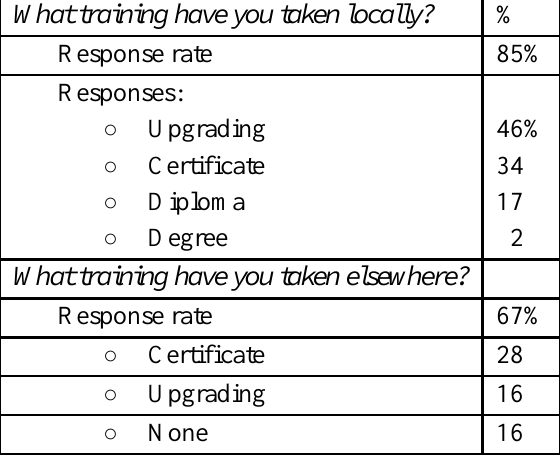
Educational and Training Experience What training have you taken